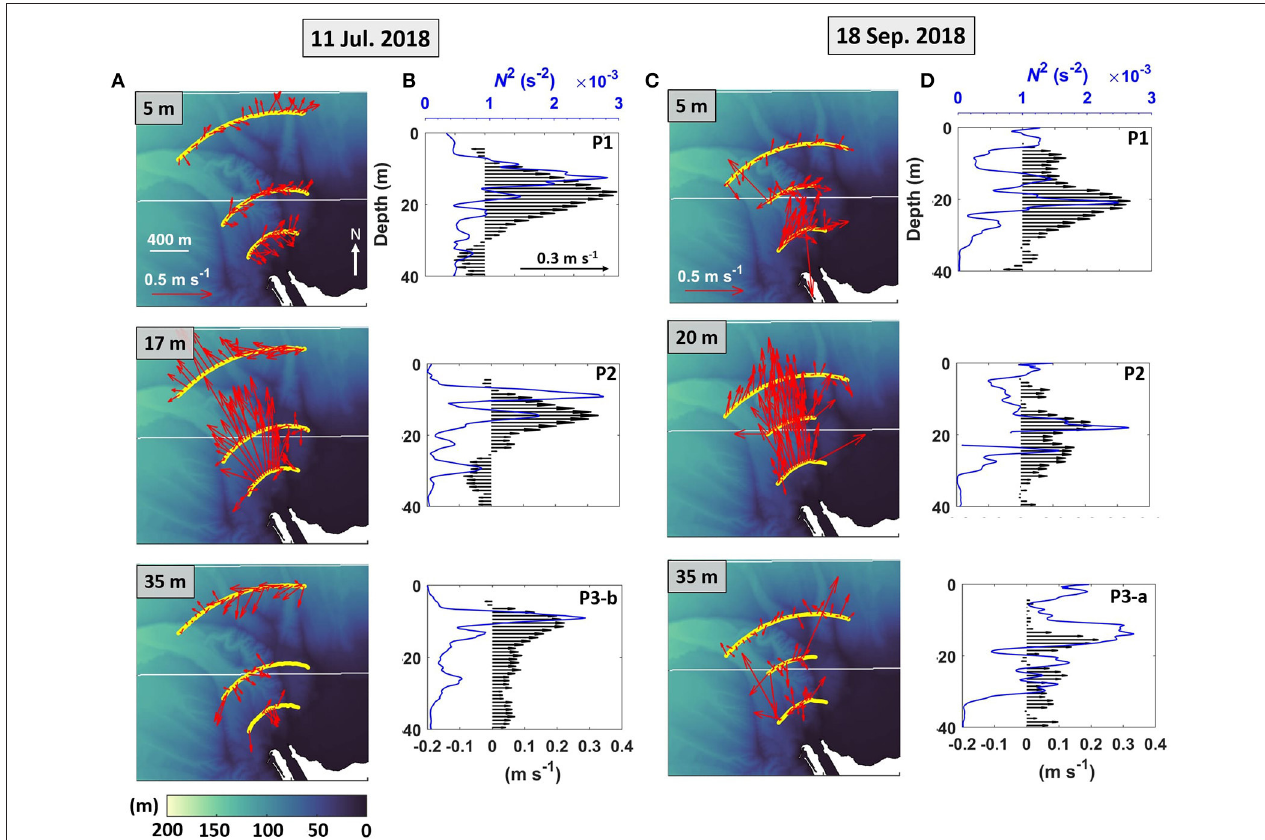
FIGURE 3 | Current measurements for the two campaigns carried out on 11 July and 18 September 2018 in Lake Geneva. Columns (A,C) Current vectors (red arrows) along the ADCP transect (T1, T2, T3-a and T3-b, yellow lines) at different depths as given in the panels. Columns (B,D) Vertical profiles of normal velocity at stations P1, P2, and P3 in the center of each curved trajectory. N 2 profiles (white lines) from Figure 2 are shown again in these panels. The colorbar gives the water depth. Reference arrows are drawn in (A,C) . See Figure 1B for